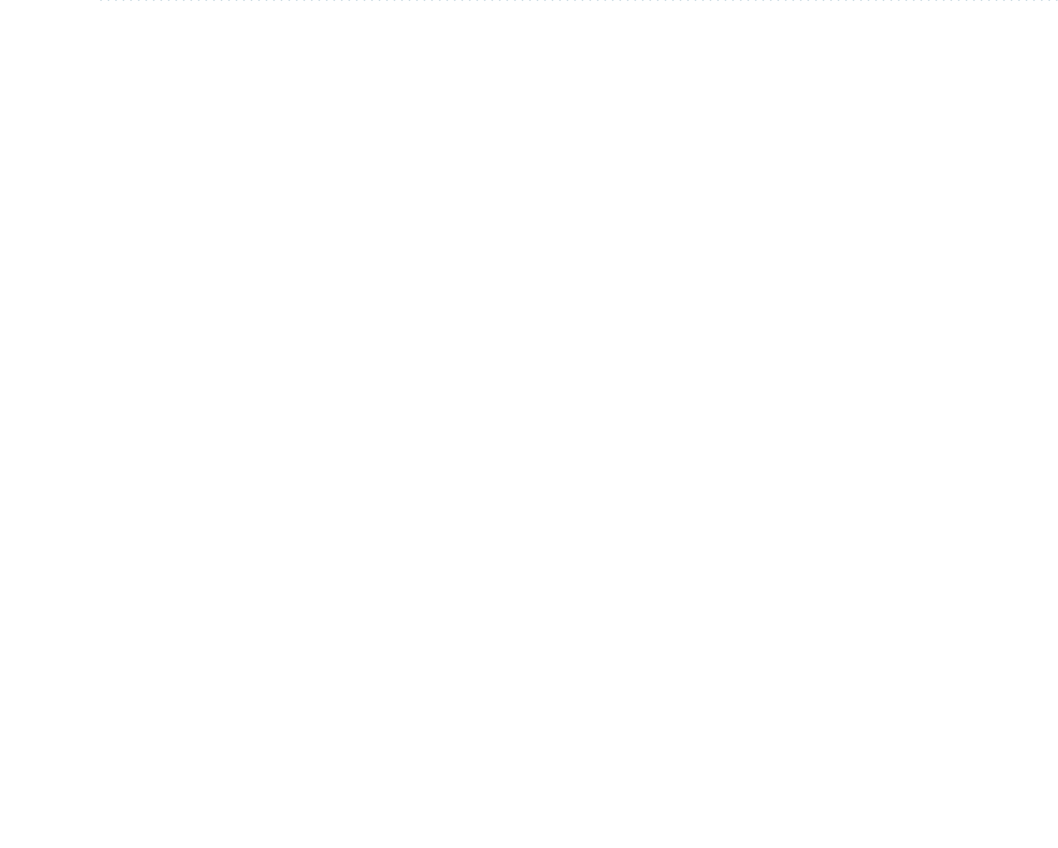
Table 10. Evaluation by event extraction and relation extraction (ten-fold cross